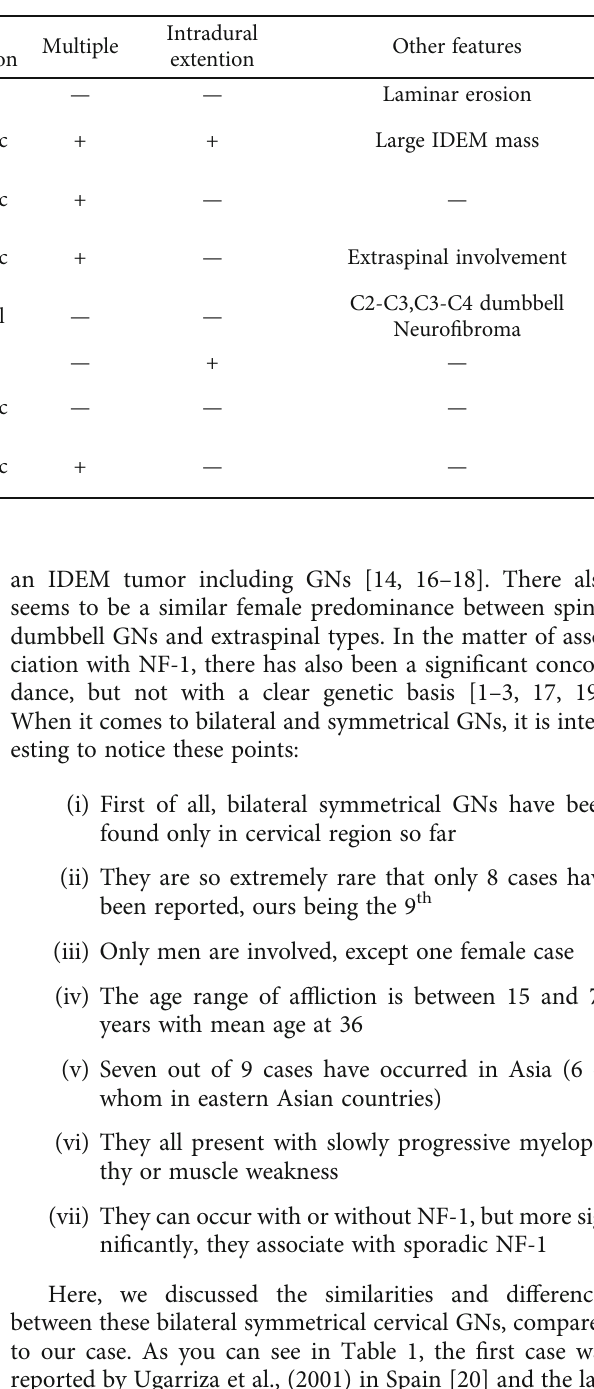
Table 1: Bilateral symmetrical cervical